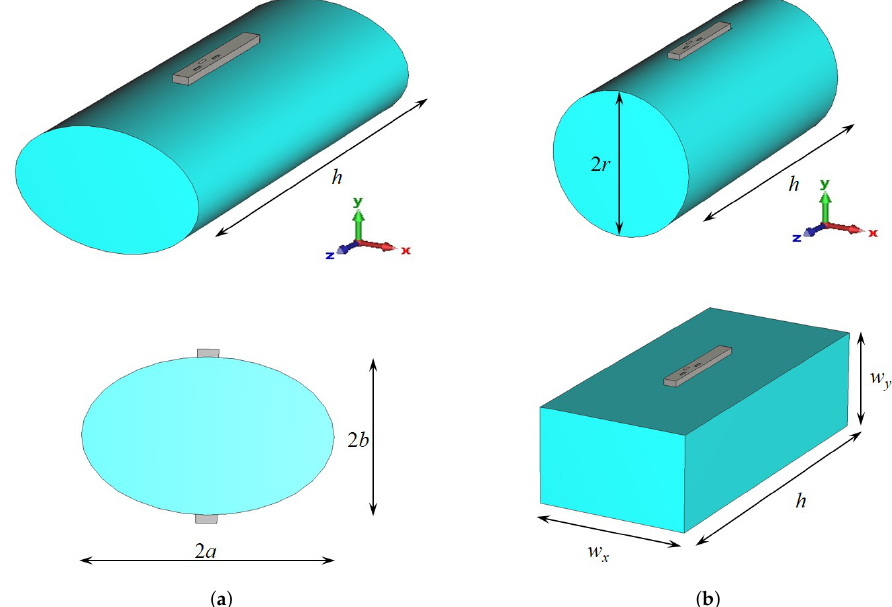
Figure 9. Sketch of the cylindrical human Phantom with waveguide antenna: ( a ) phantom with an elliptical cross-section ( a = 200 mm, b = 125 mm, h = 837 mm), ( b ) phantoms with a circular and